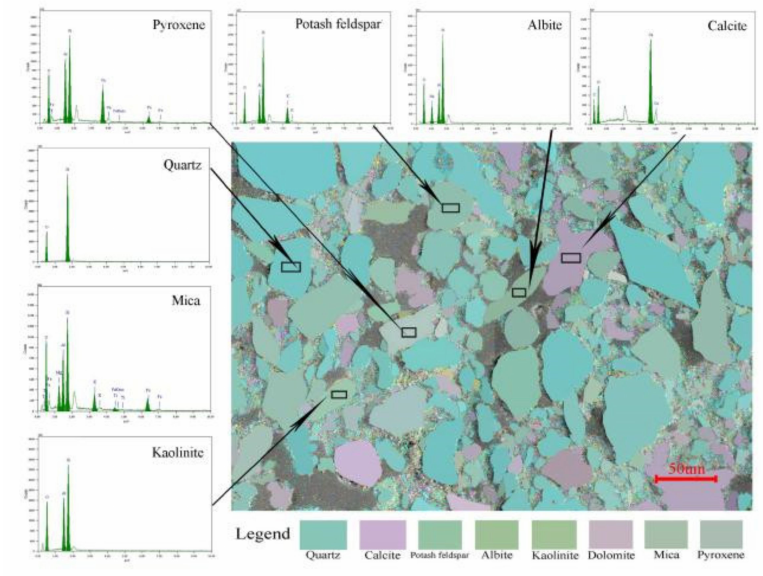
Figure 3. Standard database validation